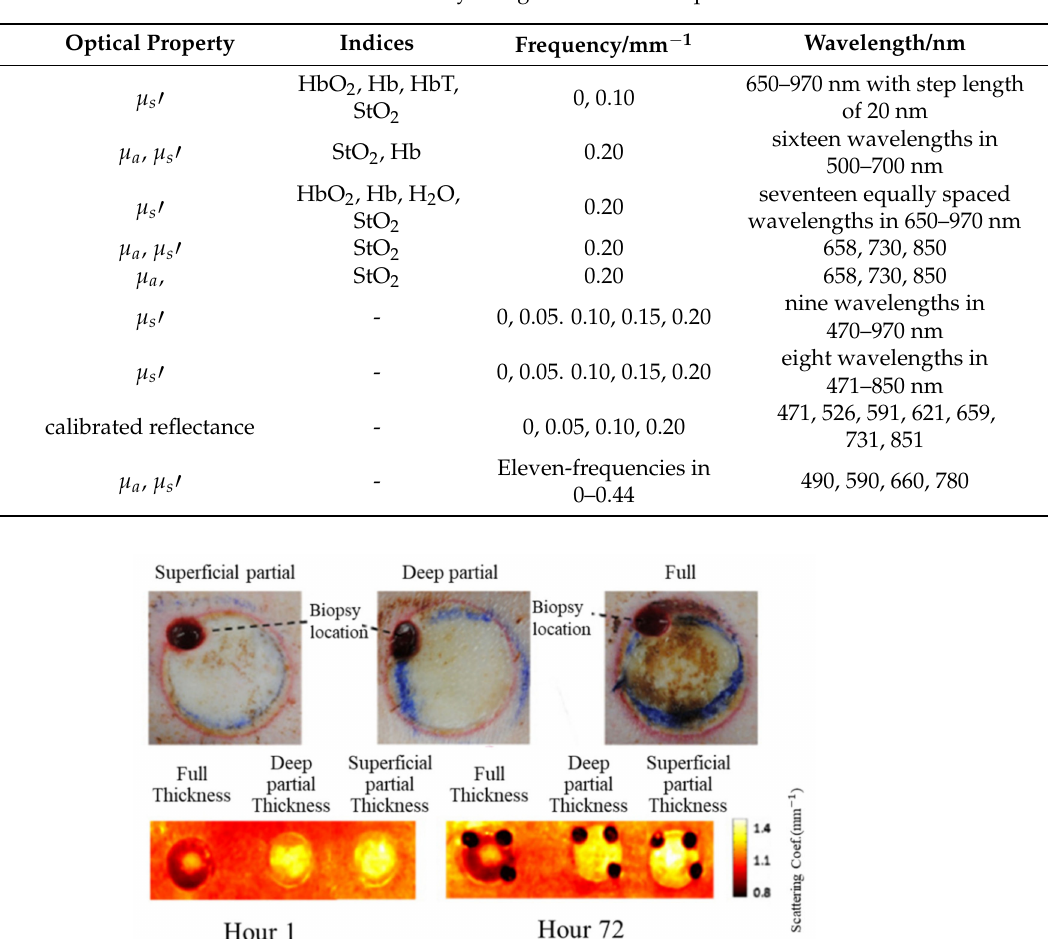
Table 2. Burn assessment by using the SFDI technique.